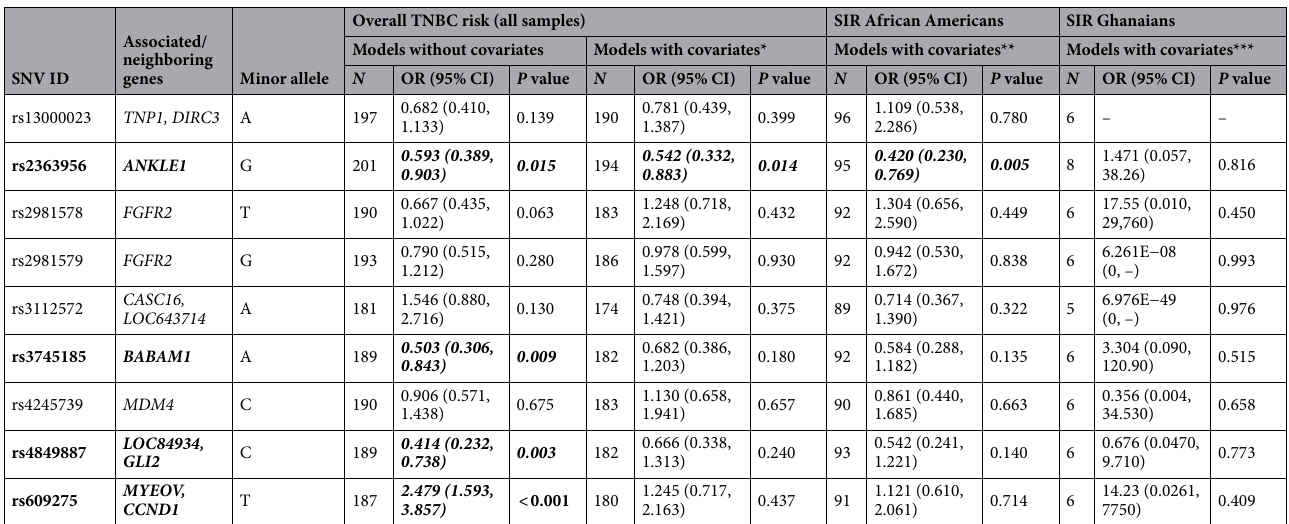
Table 3. TNBC-specific risk assessment (case-series) of previously identified variant alleles. Significant alleles ( p value < 0.05) are given in bold and italic *Overall analysis models with covariates adjusts for age and SIR. **SIR AA models with covariates adjusts for age and West African ancestry. ***SIR Ghanaian models with covariates adjusts for